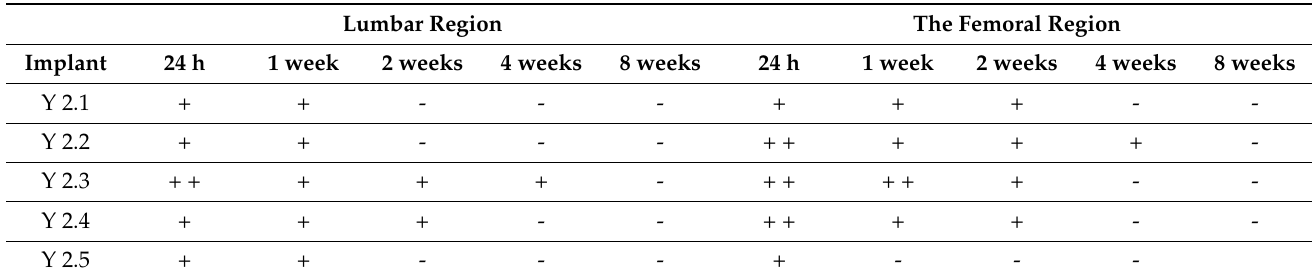
Table 2. Local reaction, Mg-0.5Ca-xY alloy pins, clinical exam results.